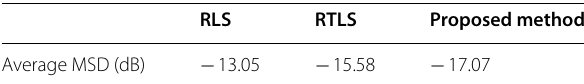
Table 2 Specifications of the LiFePO